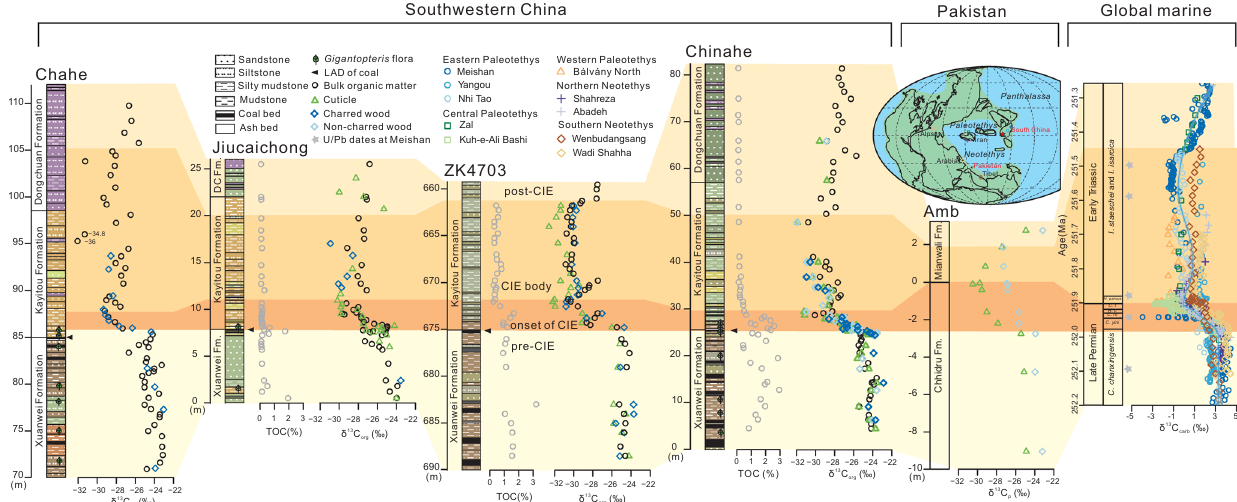
Fig. 1 Carbon isotope excursion trend recorded in global terrestrial C 3 plants and marine carbonates. The secular carbon isotope excursion (CIE) trend can be divided into four stages (i.e. pre-CIE, onset of CIE, CIE body and post-CIE) in terrestrial bulk organic matter, C 3 plants and marine carbonates, and are shown as different color fi elds. The last appearance datum (LAD) of coal beds and Gigantopteris fl ora distributions represent the coal gap and collapse of tropical peatlands respectively 10,45 . Carbon isotope ( δ 13 C) data source: Chahe ( δ 13 C of bulk organic matter from ref. 27 ; δ 13 C of plants data from this study), Jiucaichong (this study), ZK4703 core and Chinahe ( δ 13 C data in this study together with our previous work 10 ), Amb (Pakistan) 32 and global marine carbonate δ 13 C (Methods). The locations of marine and terrestrial carbon isotope pro fi les are shown in the late Permian palaeogeographic